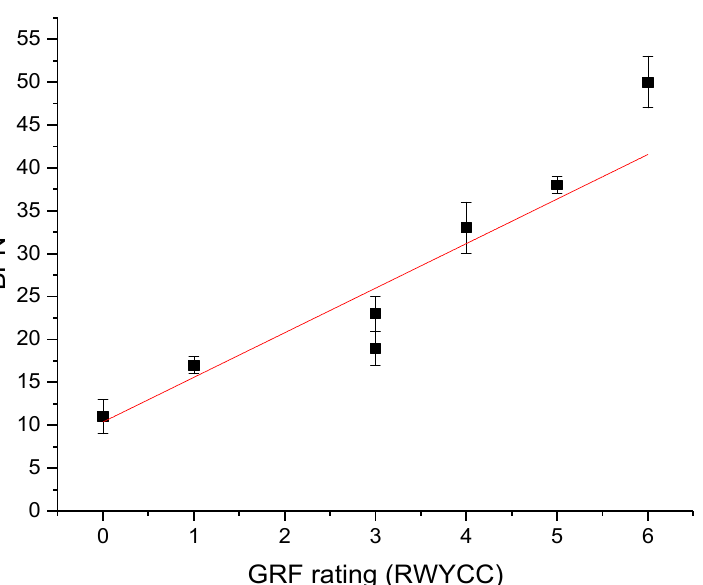
Figure 5. BPN as a function of the GRF RWYCC.